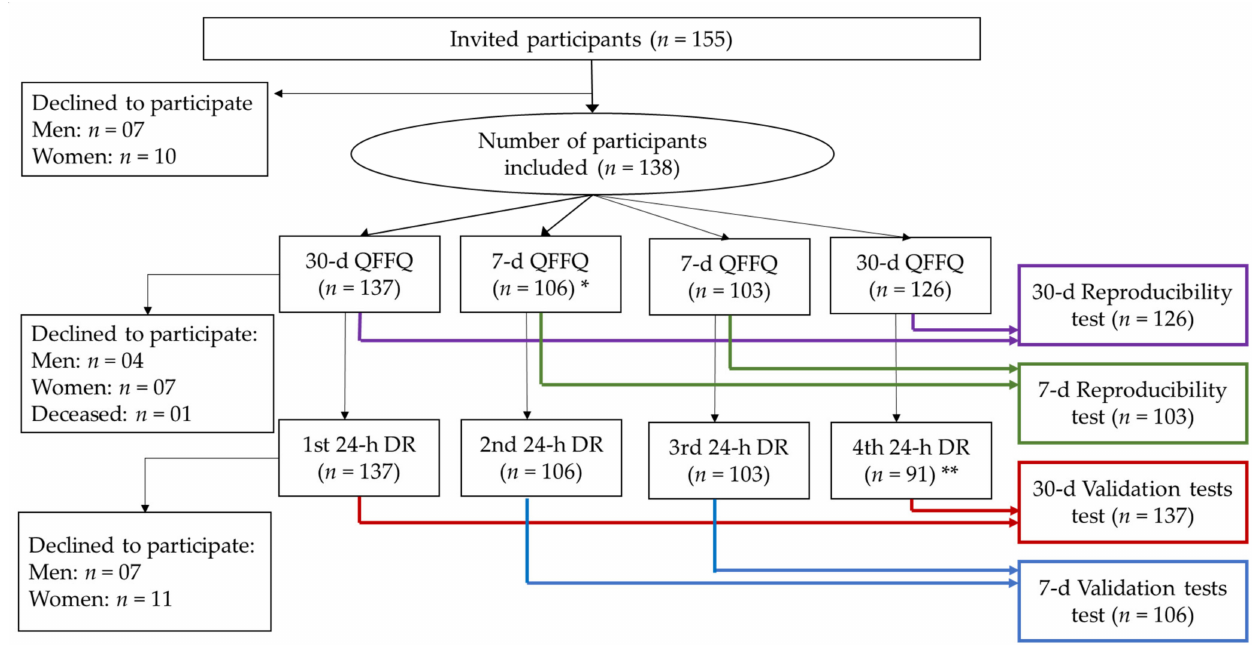
Figure 1. Participant selection and sequence of assessments flowchart. * The additional interview using the 7-day FG-QFFQ was initiated for the 28th participant onwards. Out of the 137 participants who initiated the study, 3 declined to continue in the second visit. ** The fourth interview using the 24-h dietary recall was initiated for the 28th participant onwards. Out of the 137 participants who initiated the study, 18 did not respond to the fourth